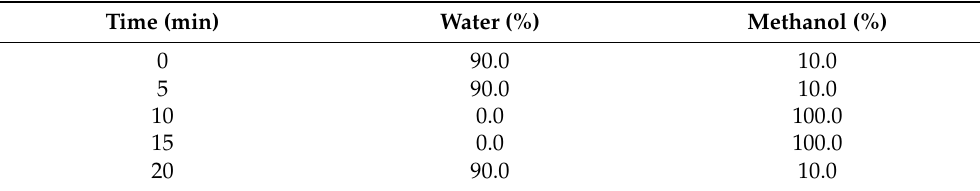
Table 1. Gradient elution conditions for HPLC–UV